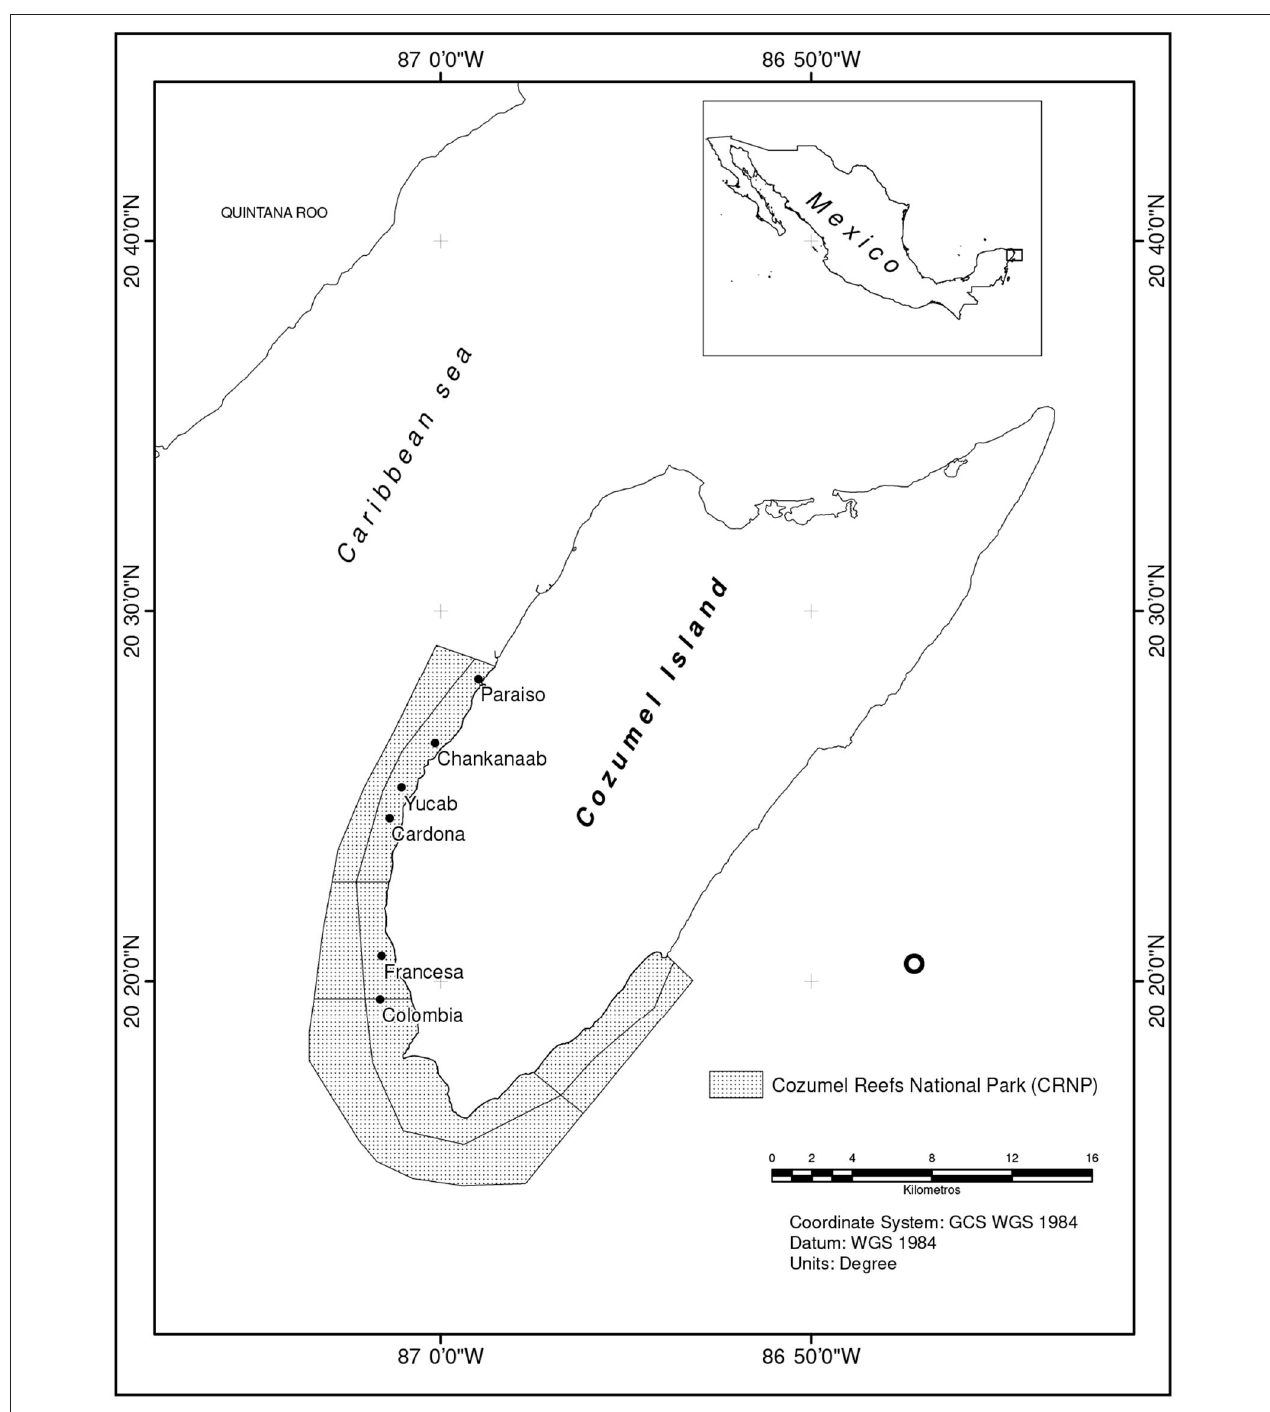
FIGURE 1 | Location of six reefs within the Cozumel Reefs National Park, where comparisons between sampling designs were performed.